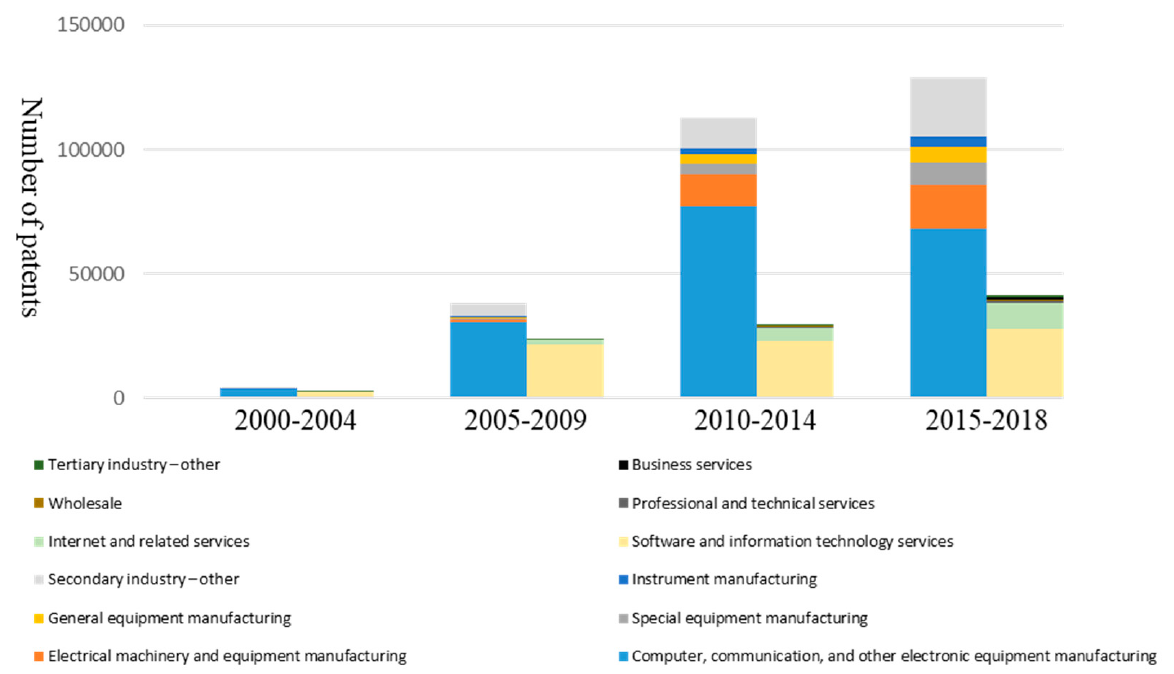
Figure 1. Numbers of patents in the secondary and tertiary industries in Shenzhen from 2000 to 2018.